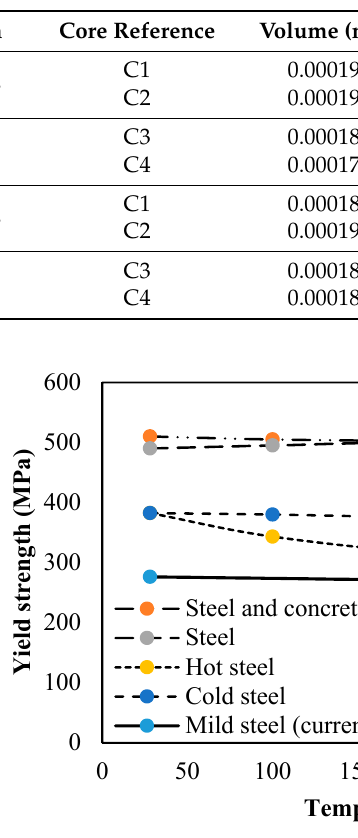
Table 5. Density ( ρ ) (kg/m 3 ) of PC and HVFANS slabs before and after firing.